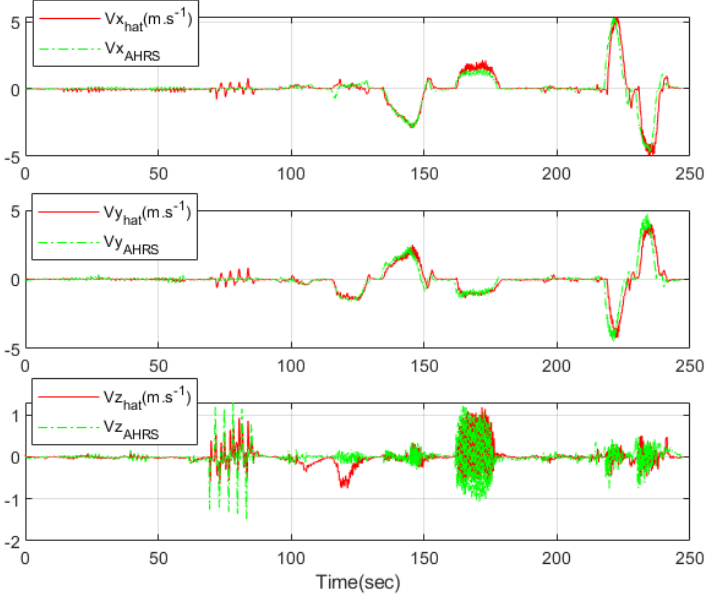
Figure 21. The 3-axis velocities of the athlete: comparison with Microstraion’s AHRS. Figure 22 shows the attitude of the athlete for the comparison experiment. The green lines are the estimated attitude of Microstrain’s 3DM-GX5 GNSS/IMU AHRS and the blue lines are the attitude estimated using the designed integration filter of the wearable EPTS. The estimated and high-precision GNSS/IMU AHRS results (except yaw angle) are similar, as shown in Figure 22. The difference in the yaw angle estimates may occur because the gyroscope data of the considered wearable EPTS were only used to